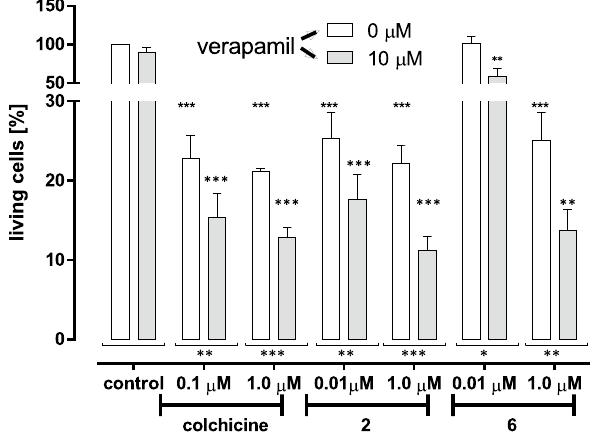
Figure 8. Impact of verapamil (ABCB 1 inhibitor) on cytotoxic activity of tested compounds: colchicine, 2 and 6 . Statistical significances between groups treated without verapamil are marked with asterisks (*) p < 0.05; (**) p < 0.01; (***) p < 0.001. Statistical significances between groups treated with verapamil are marked with asterisks (*) p < 0.05; (**) p < 0.01; (***) p < 0.001. Statistical significances between groups treated with the same concentration of tested compound but with or without verapamil are marked with asterisks (*) p < 0.05; (**) p < 0.01; (***) p < 0.001. (ANOVA F(3, 33) = 16.5; p = 0.0000).